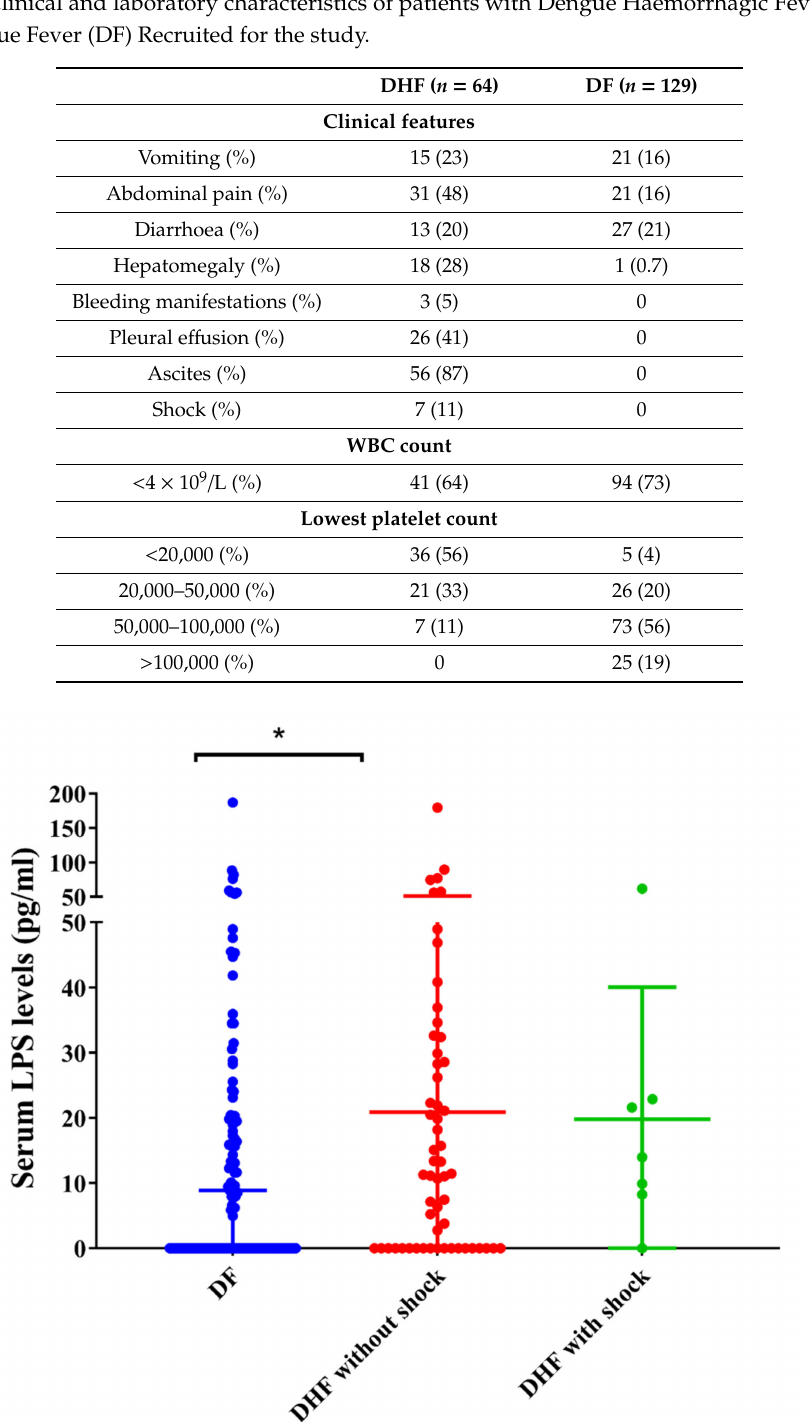
Figure 1. Lipopolysaccharide (LPS) levels in patients with acute dengue. LPS levels were measured by ELISA in patients with acute (A) DF ( n = 129, indicated in red), DHF ( n = 57, indicated in blue), and DSS ( n = 7, indicated in green) during day 4 (SD ± 1) of illness. Error bars indicate the median and interquartile range (IQR). * p <